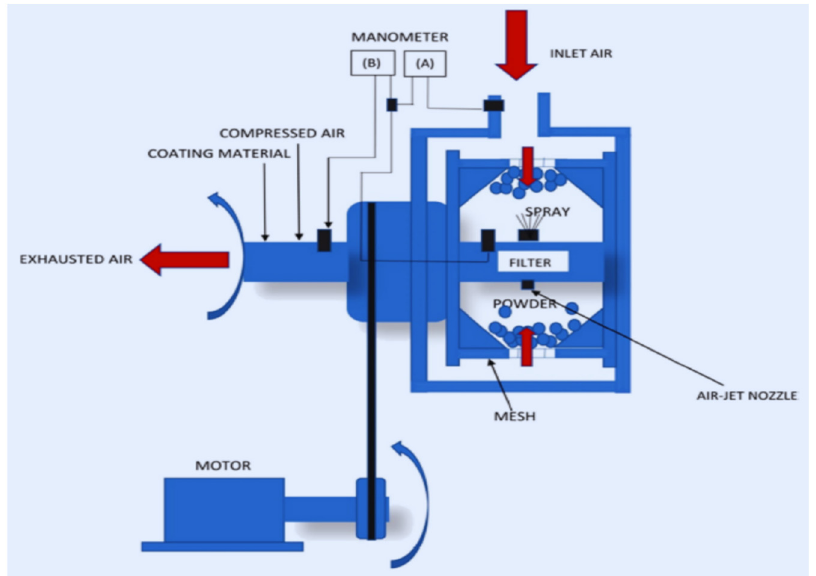
Figure 9. Fluidized-bed application method for edible coatings. Adopted from [194] with permis- sion. Table 3. List of application methods for edible coatings on food products prepared from marine biopolymers. Biopolymer